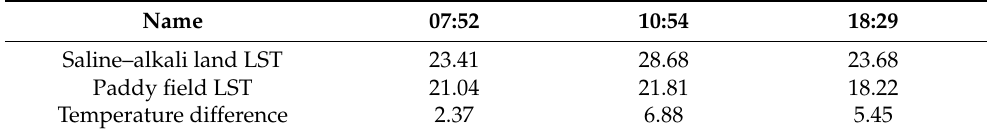
Table 4. The daytime surface temperature difference ( ◦ C) between saline–alkali land and paddy